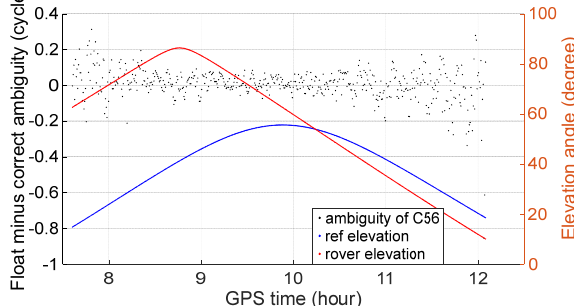
Figure 2. Ambiguity resolution of extra ‐ wide lane C56.